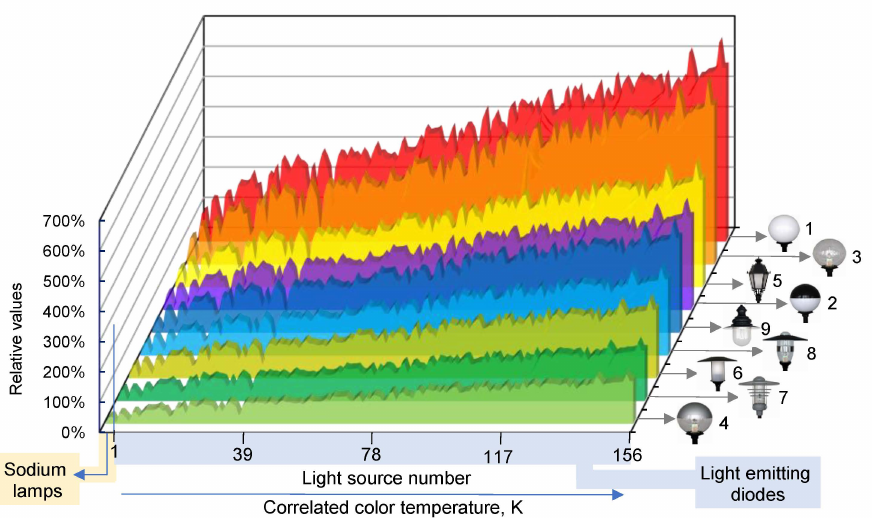
Figure 15. Relative influence on the effect of light pollution by luminaires with identical values of luminous flux and light sources that differ from each other by CCT